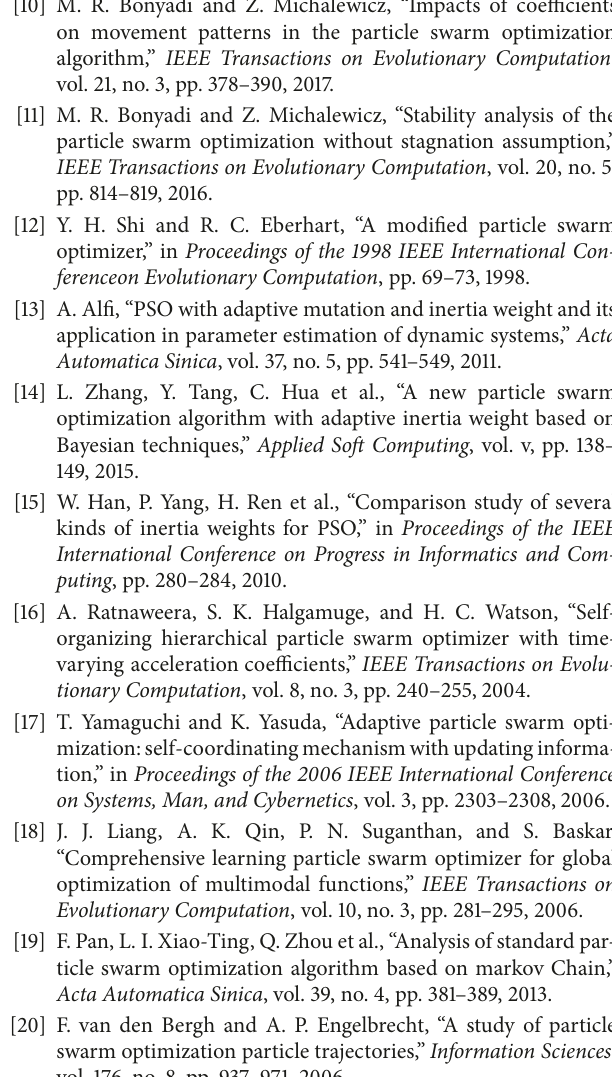
Algorithm00.511.522.533.54 m e T i Figure 13: Average runtime comparison of the 6 algorithms (Sphere